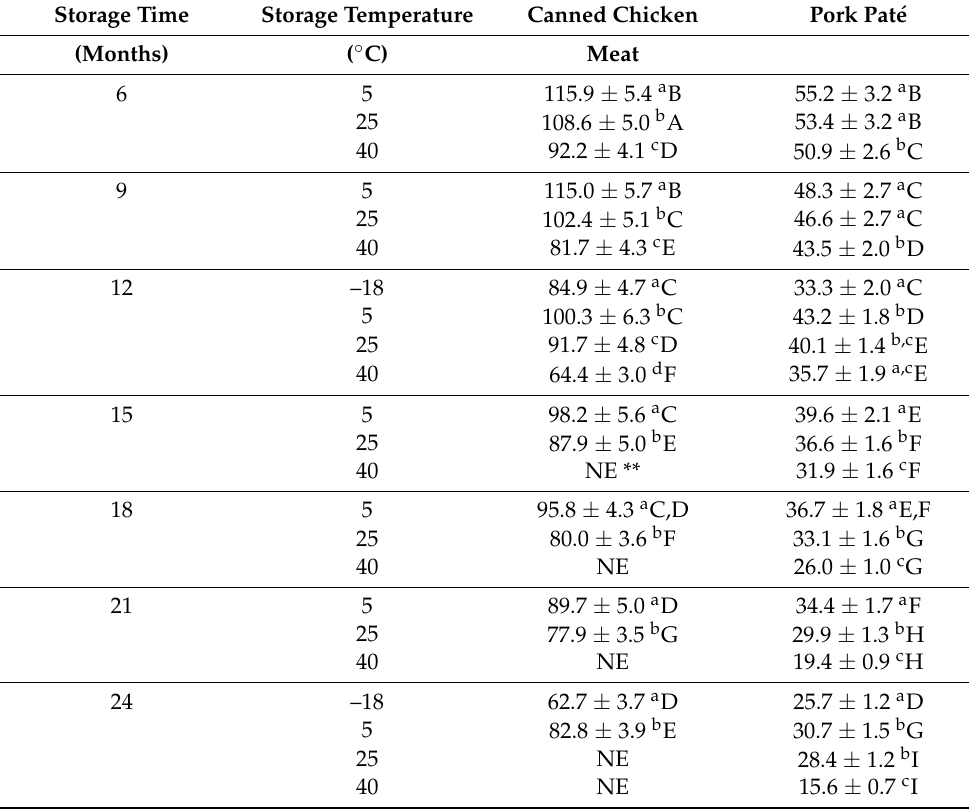
Table 4. Cont. Storage